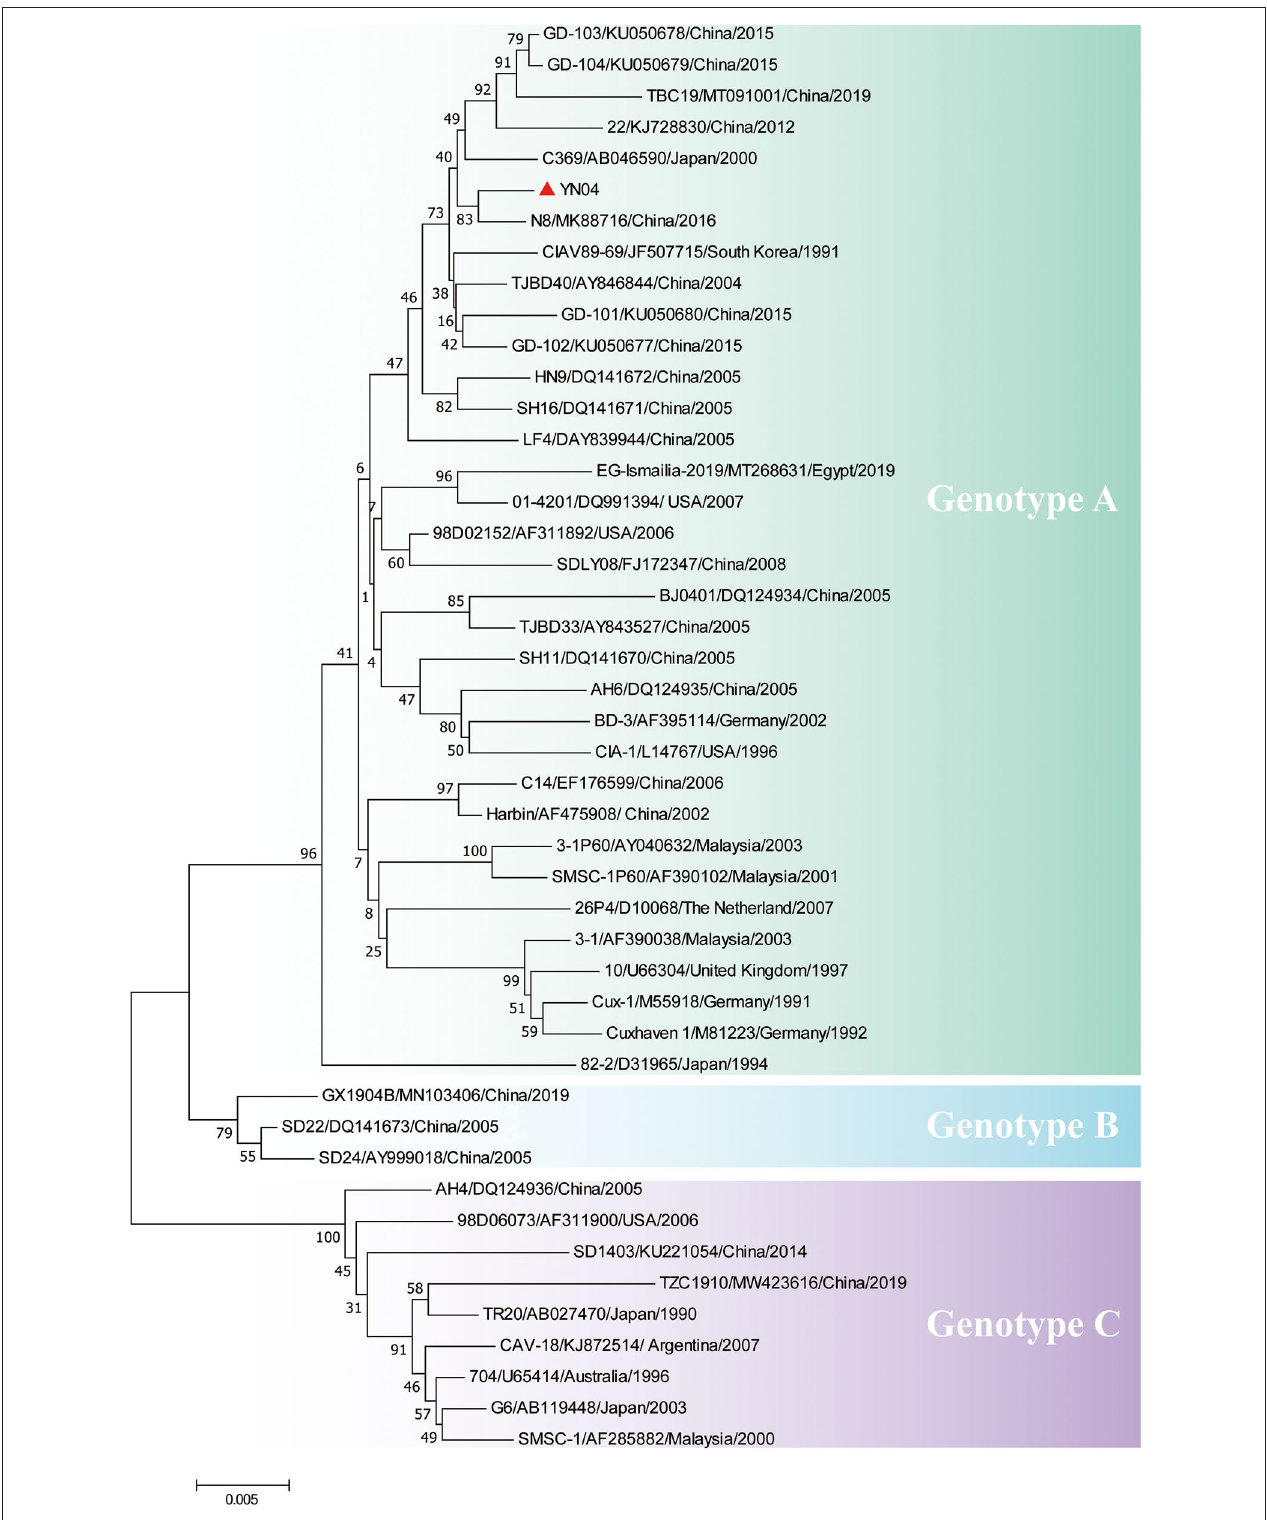
FIGURE 2 | Phylogenetic analysis of YN04 based on whole genome sequence. The genomic nucleotide sequences of the YN04 strain, along with 45 chicken anemia virus (CAV) genome sequences downloaded from the GenBank database, were used for phylogenic analysis by the neighbor-joining method, with phylogenetic distances calculated using MEGA 7.0 software. Bootstrap values obtained from 1,000 replicates are shown at the major nodes. The genogroups are indicated. The strains isolated in this study are indicated by solid dots.